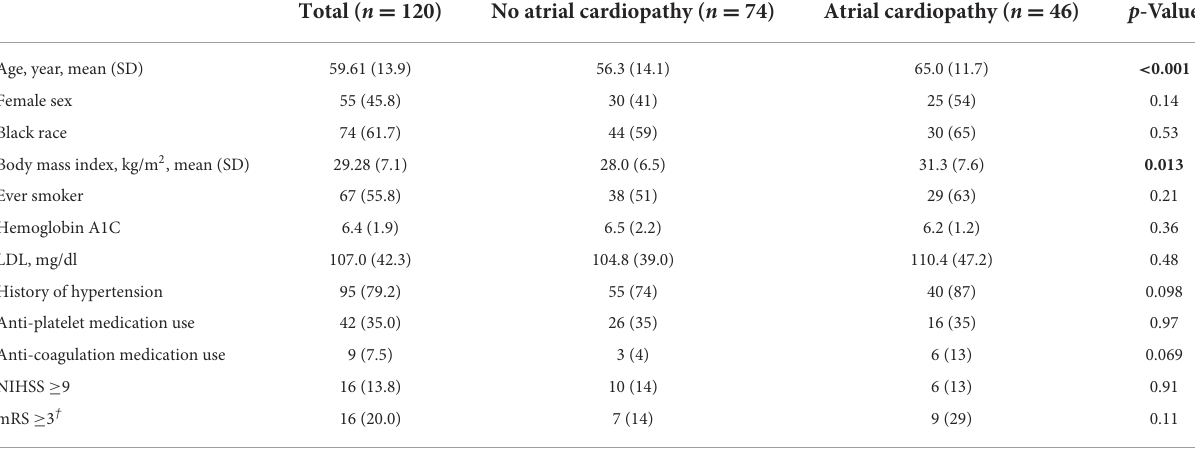
TABLE 1 Patient characteristics.